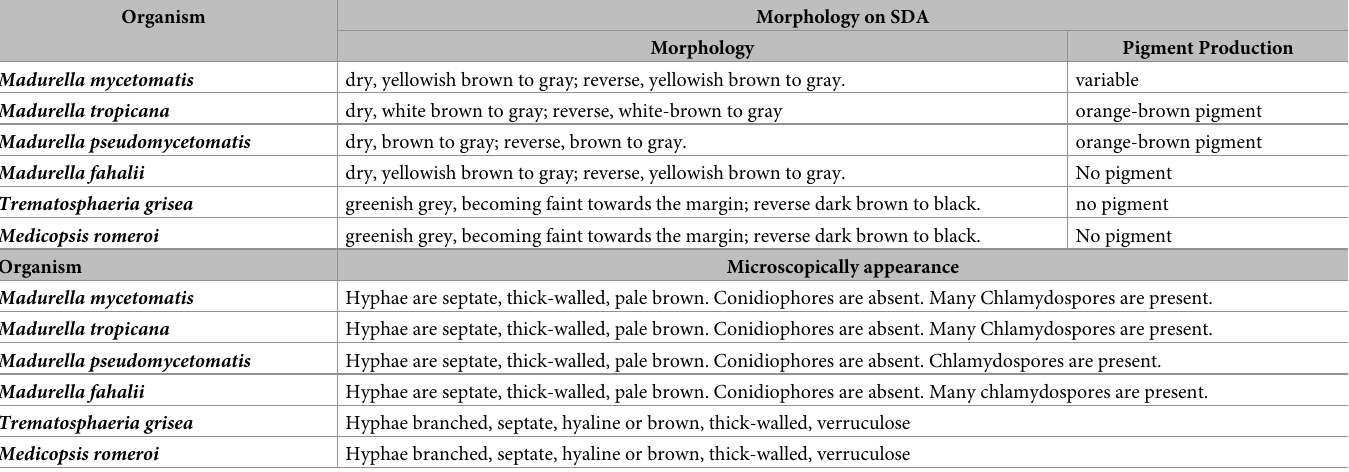
Table 1. Macroscopical and microscopical characteristic of different Madurella